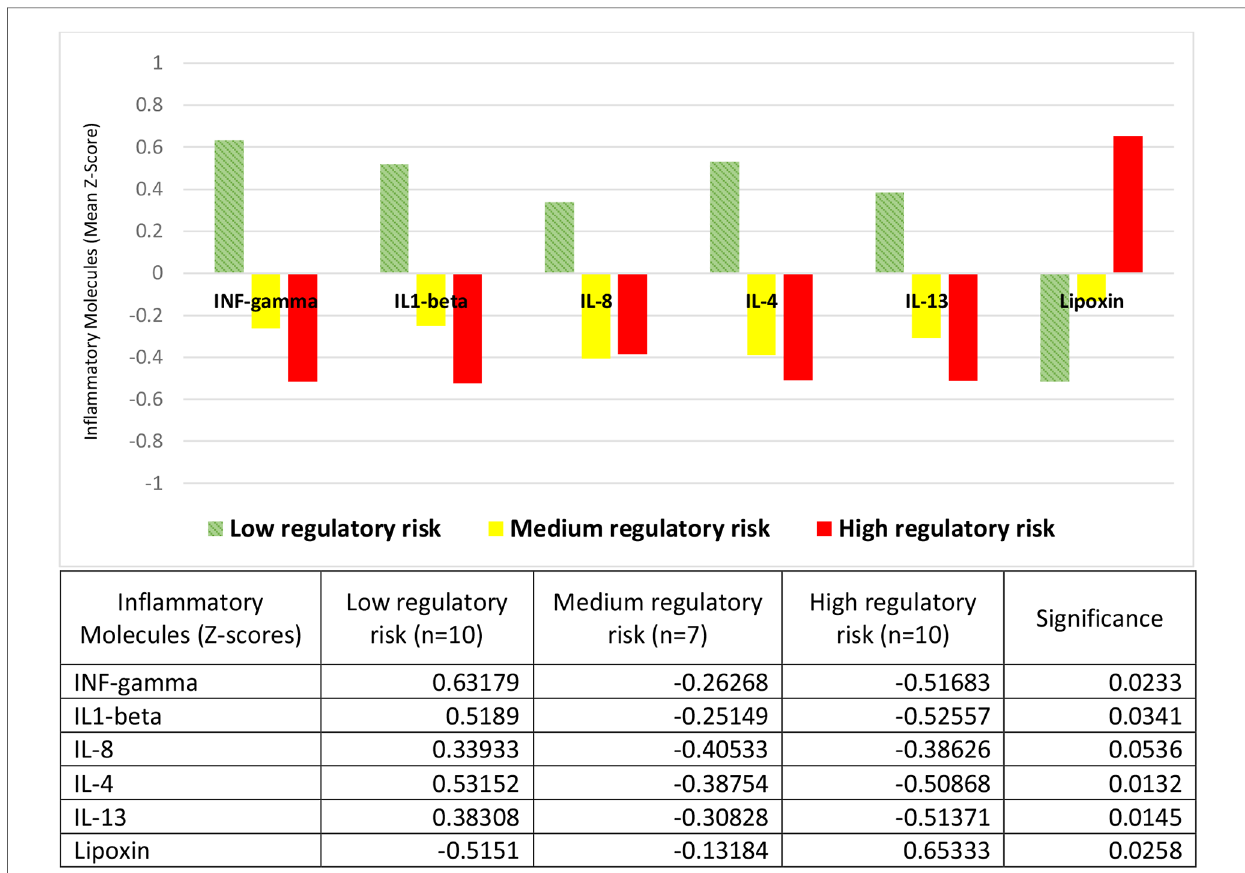
FIGURE 2 In fl ammatory molecules and risk of regulatory disorders. Children at low regulatory risk had positive Z -scores for the mean concentrations of the proin fl ammatory molecules INF-gamma, IL1-beta and IL-8, and the anti-in fl ammatory molecules IL-4 and IL-13; and negative Z -scores for the pro- resolving molecule lipoxin. The Z -scores of the other two groups (medium and high regulatory risk) had the opposite sign, except for lipoxin in the medium-risk group, which had negative Z -scores like the low-risk children. The table expresses the complete numerical data and the signi fi cances across the